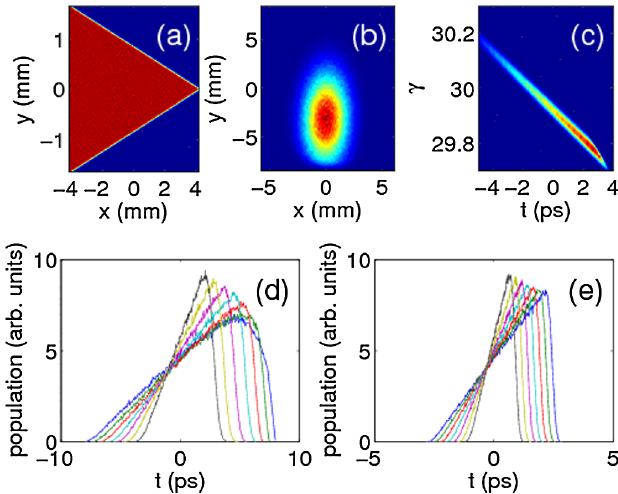
FIG. 8. Example of the generation of linearly ramped current profile from an initial uniform triangular distribution in the ð x; y Þ space (a) shown with corresponding final transverse distribution (b) and longitudinal phase space (c) downstream of the EEX beam Þ ¼ ; " n line. The initial normalized emittance partition is ð " n FIG. 9. Example of mask shape needed to generate a linearly x; 0 z; 0 ð 10 ; 1 Þ (cid:14) m and ð (cid:3) ; (cid:1) ; Þ ¼ ð 2 ; 12 m Þ . The current profiles ramped horizontal profile by interception of beam with trans- x; 0 x; 0 downstream of the EEX beam line are shown in plots (d) and verse radial Gaussian density (a). The mask profile used is Þ ¼ ð 10 ; 1 Þ and ð 1 ; 10 Þ (cid:14) m . The ; " n (e) for, respectively, ð " n described by Eq. (22) and only macroparticles with j y j (cid:7) (cid:13) ð x Þ x; 0 z; 0 are kept resulting in the transverse charge density shown in (b). incoming horizontal C-S parameters are a betatron function of The initial Gaussian horizontal profile (c) is transformed into a 12 m and the (cid:3) function was varied by an increment of 1 from (cid:1) 4 linear-ramped horizontal profile (d). For this example the initial to þ 2 [corresponding to the seven traces shown in plots (d) and ¼ 1 : 4 mm and (cid:10) ¼ 2 : 5 mm and transverse beam sizes are (cid:10) (e)]. The initial beam Lorentz factor for these simulations is x y ¼ 100 and g ¼ 3 (cid:4) 10 4 (cid:9) ¼ 30 . The head of the bunch corresponds to t < 0 . the parameters in Eq. (22) are g 0 1